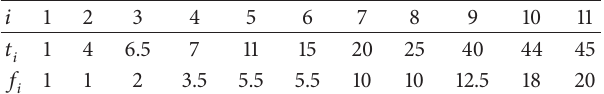
Table 3: A 2D monotone dataset.